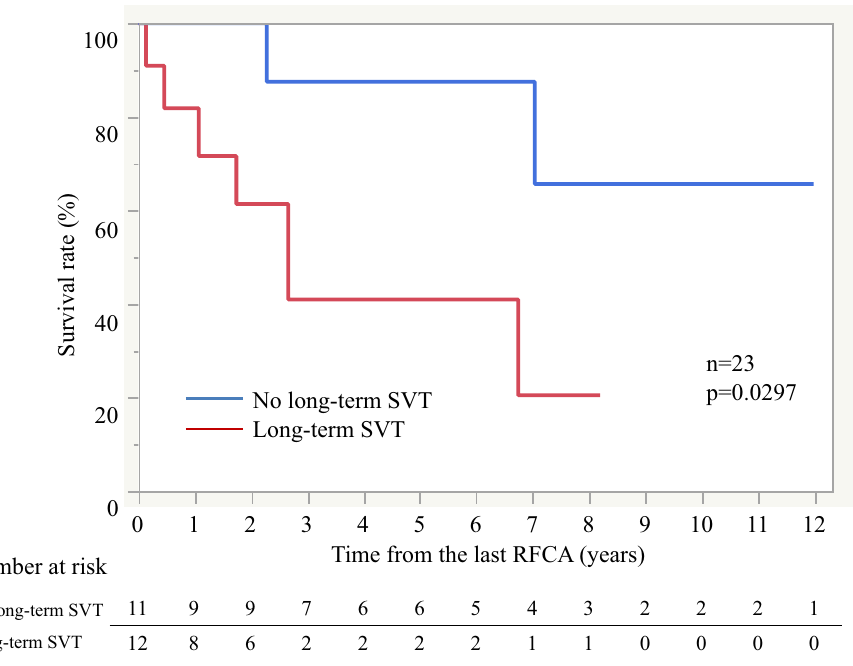
Figure 4. Kaplan-Myer survival curves between with and without SVT after the last RFCA. RFCA: radiofrequency catheter ablation, SVT: supraventricular